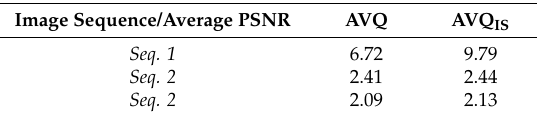
Table 2. Average C.R.–Dataset 1.